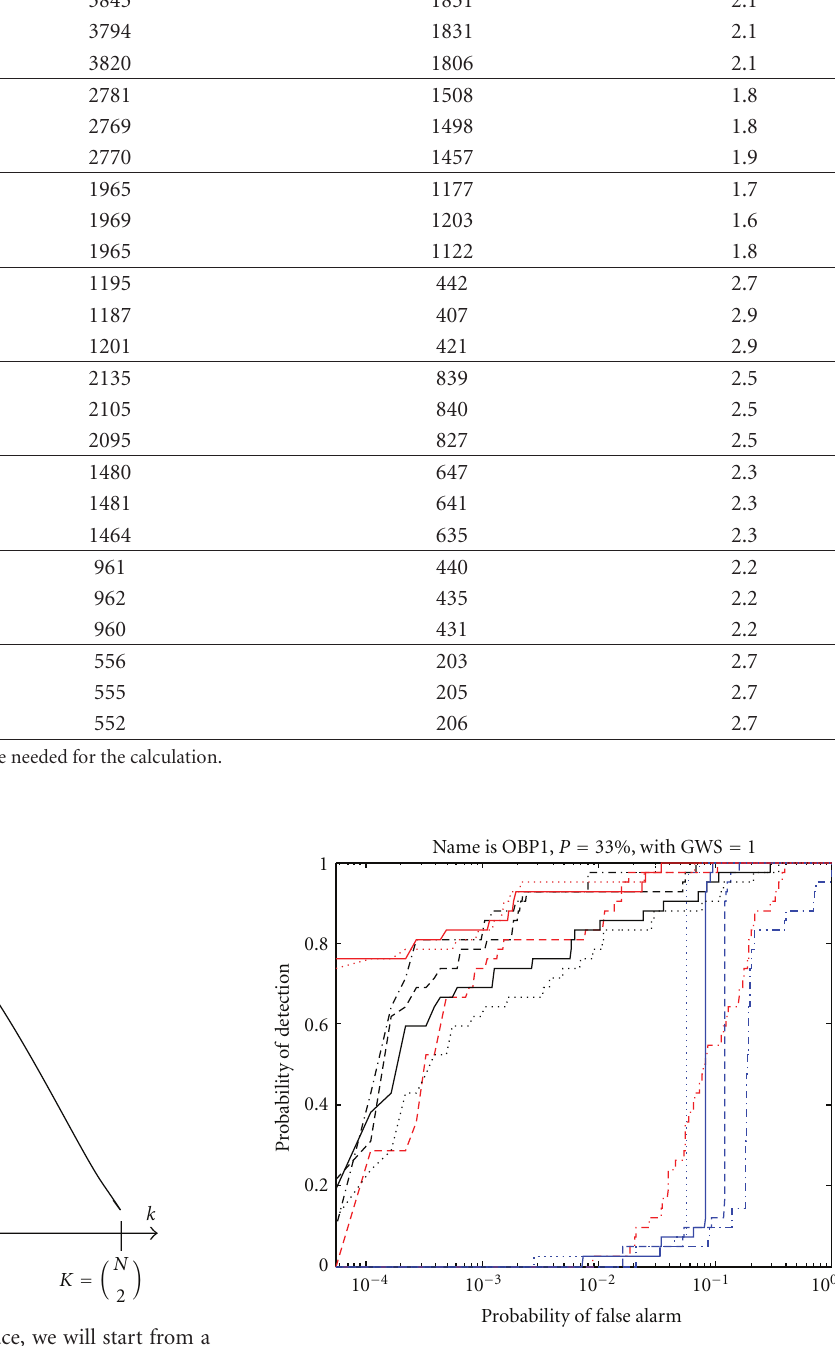
Figure 6: When starting from PCA subspace, we will start from a closer point to the maximum so we need fewer rotations; the delta in k between the original location to the current one is the rotations done by transforming to the PCA subspace.